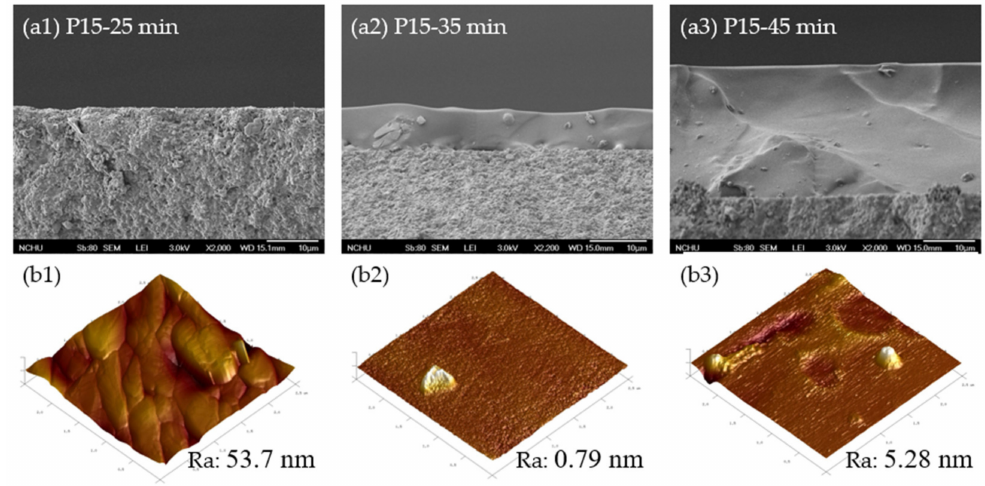
Figure 5. SEM ( a ) and AFM ( b ) images of the P15 membrane prepared at different reaction times ( a1 , b1 ) 25 min, ( a2 , b2 ) 35 min and ( a3 , b3 ) 45